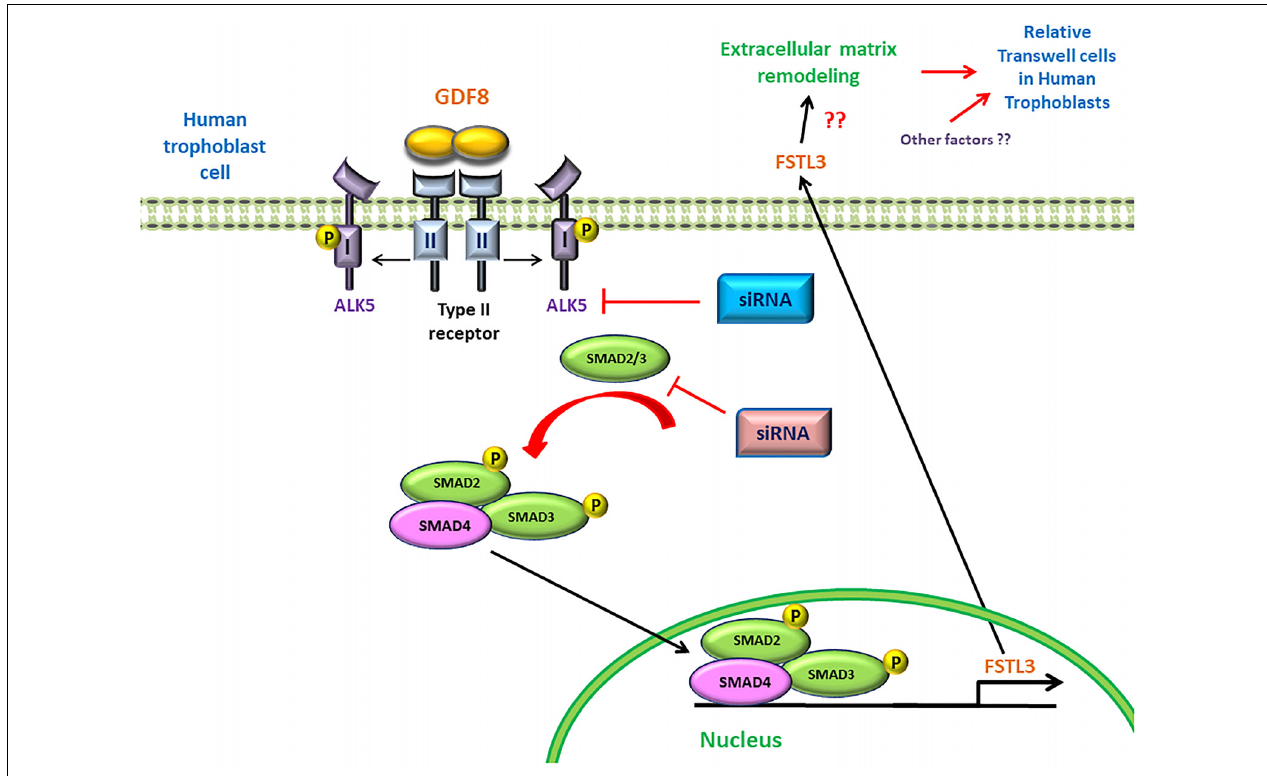
FIGURE 7 | Proposed model of the stimulatory effect of growth differentiation factor 8 (GDF8) on relative transwell cells in human trophoblast cells. GDF8 binds to a heterotetrameric receptor complex comprised of type I (ALK5) and type II receptors. Ligand-induced activation of the receptor complex results in the phosphorylation and activation of ALK5, leading to the activation of receptor-regulated SMAD2 and SMAD3. Phosphorylated SMAD2 and SMAD3 form a heterotrimeric complex with common SMAD4 that translocates into the nucleus where it binds the FSTL3 promoter and stimulates the transcription and secretion of FSTL3, which in turn promotes cell invasion of human trophoblast